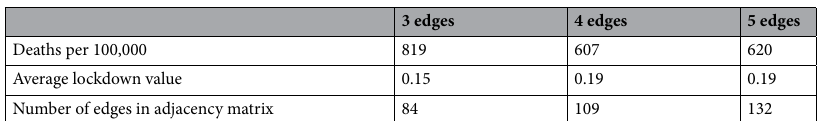
3 edges 4 edges 5